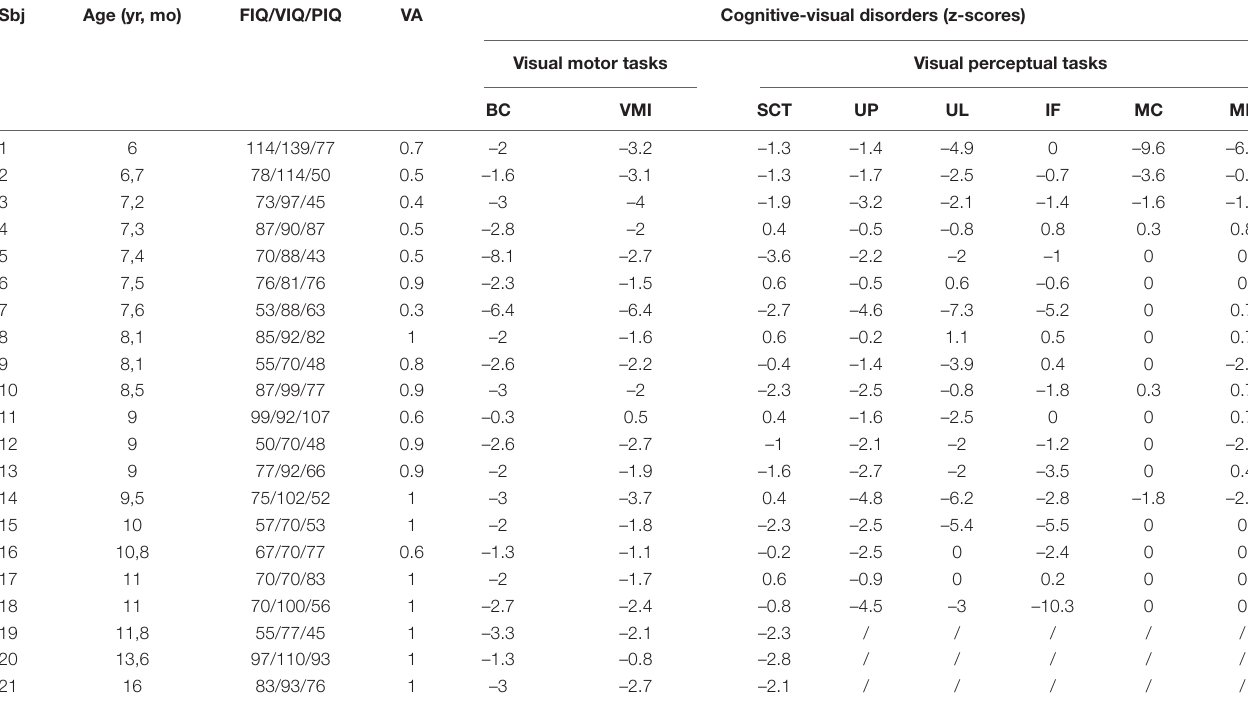
TABLE 3 | Details on cognitive visual tasks of children with a CVD (belonging to subgroup 3).